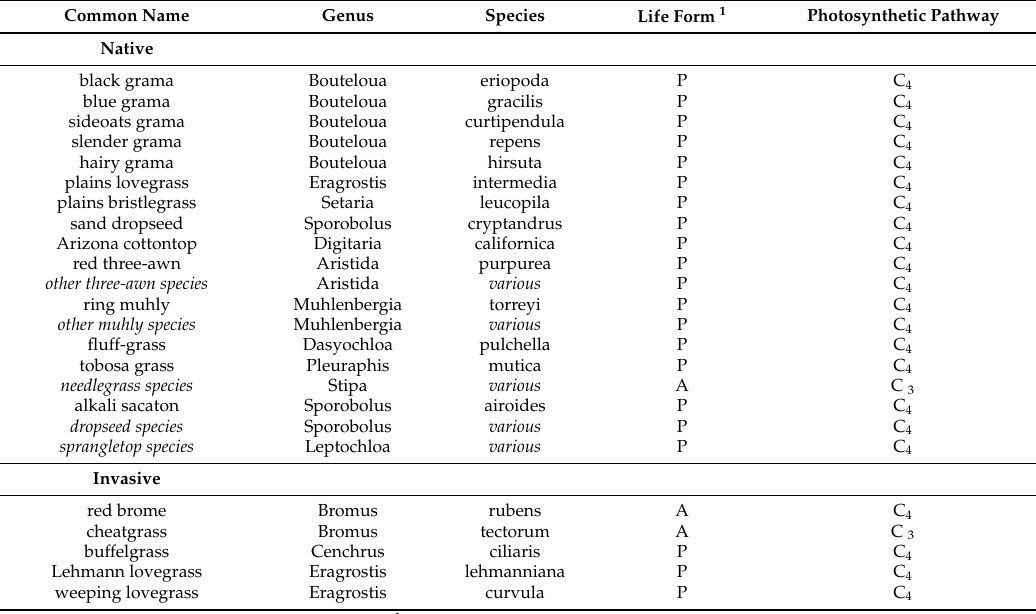
Figure 3. Average (mean) monthly total precipitation for years 2000–2014 at Picacho, Arizona (elevation 492 m) and Elgin, Arizona (elevation 1441 m) [75]. Site locations are displayed in Figure 2.